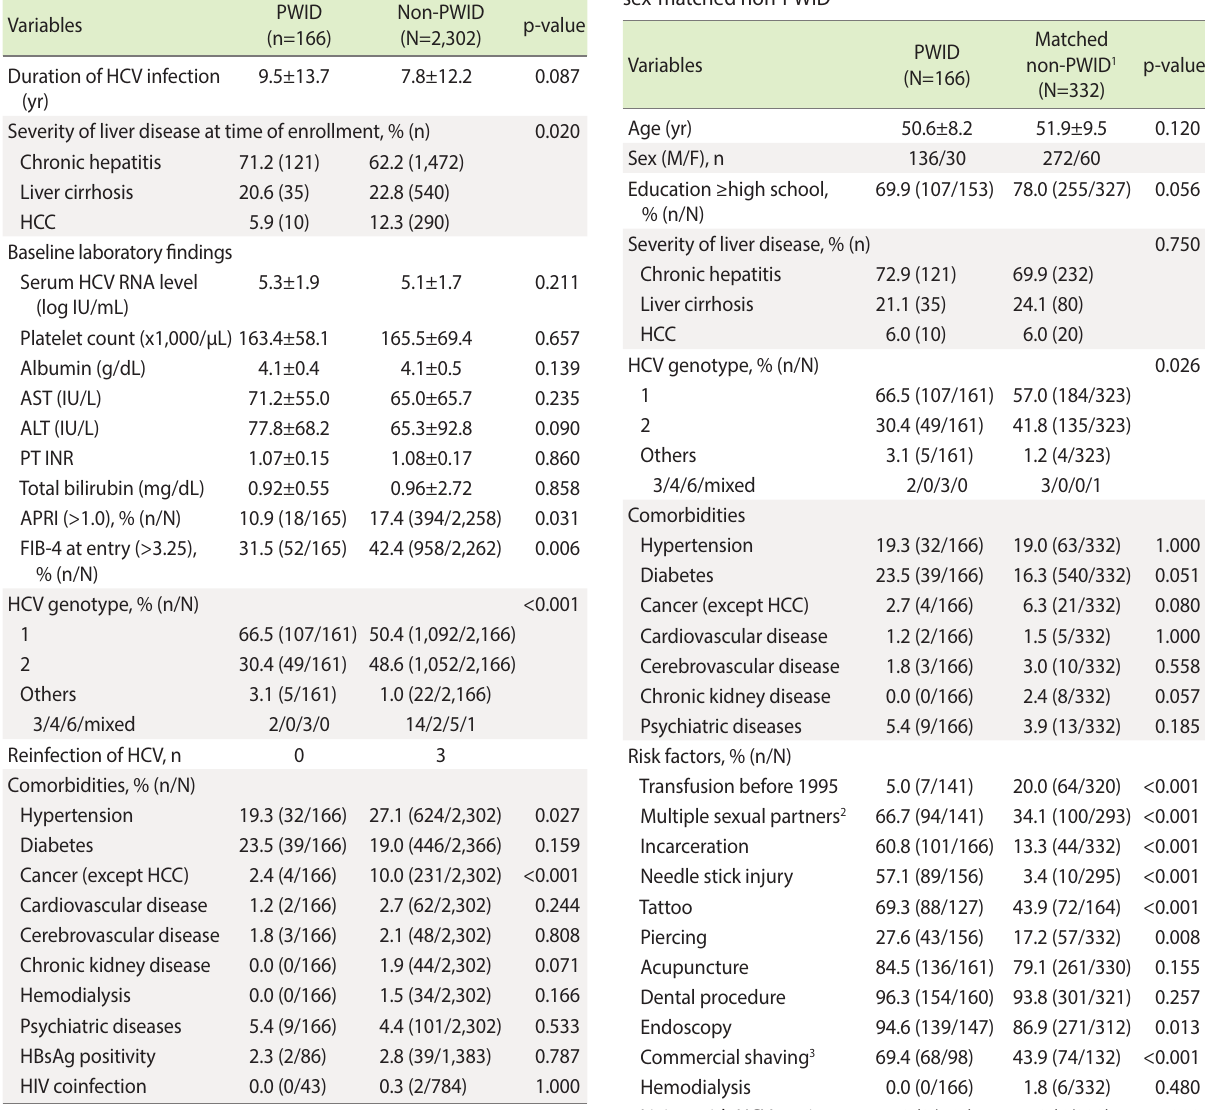
Table 3. Comparison of liver disease status, comorbidities, and ex- posure to risk factors for HCV infection between PWID and